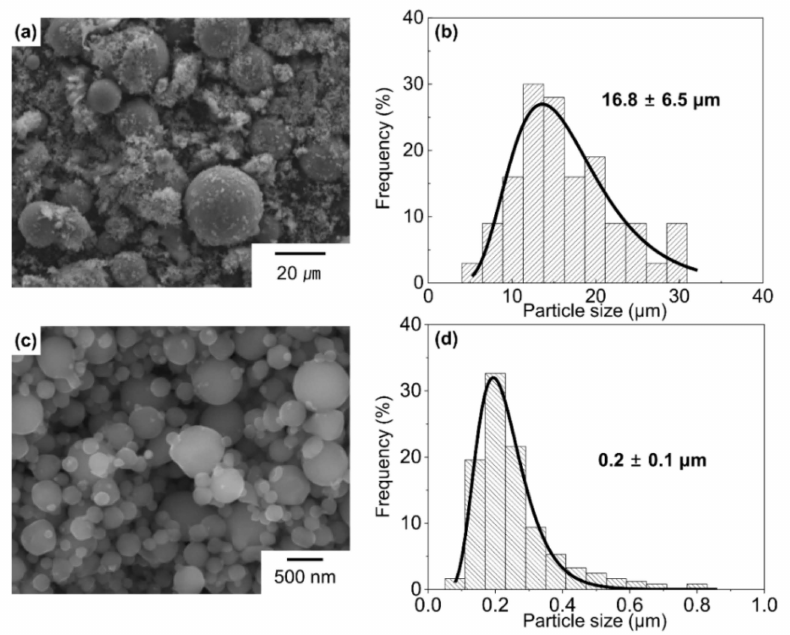
Figure 2. FE-SEM image of large Al particles fabricated from Al powder processed with LO-ITP at ( a ) low magnification. ( b ) Particle size distribution of large Al particles. FE-SEM image of fine Al particles fabricated from Al powder processed with LO-ITP at ( c ) high magnification. ( d ) Particle size distribution of fine Al particles (the average particle size and standard deviation were indicated in ( b , d